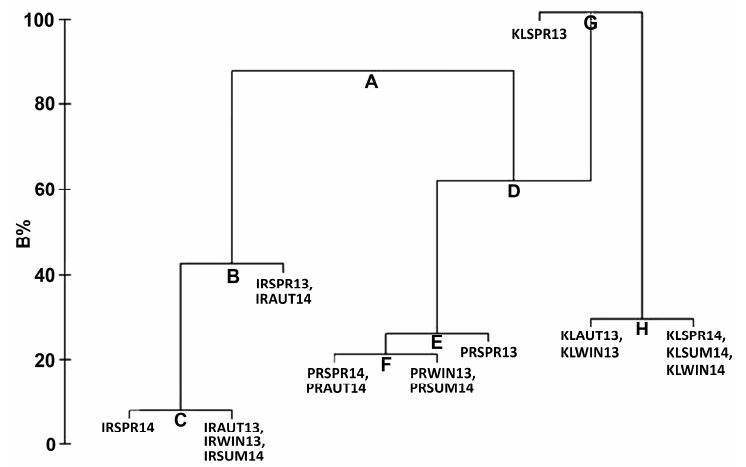
Figure 8. Dendrogram (LINKAGETREE) based on the physical parameters measured in the water column and the community structure on the artificial reefs. Ierissos: IR; Kalymnos: KL; Preveza: PR; Spring: SPR; Summer: SUM; Autumn: AUT; Winter: WIN; 13 and 14 indicate the years 2013 and 2014, respectively.